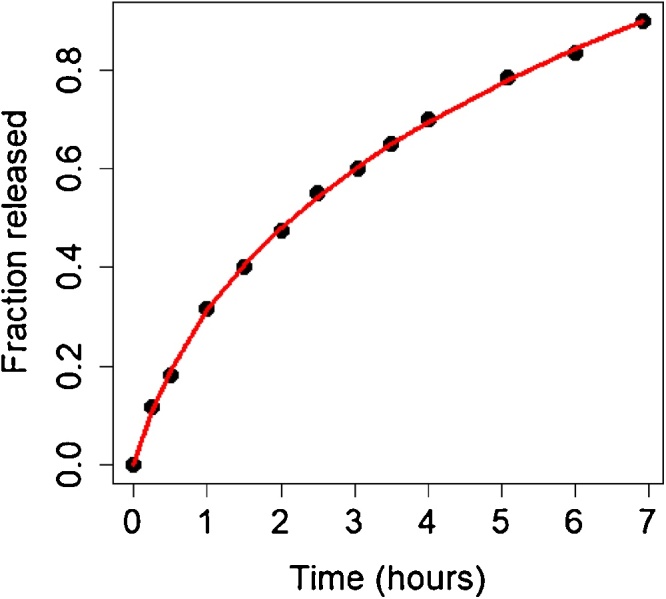
The experimental data points are accurately reproduced by a Monte Carlo heuristics, in which the predominant term in MCS is the deterministic one. Therefore, a Weibull model as defined in Eq. (3) (red curve) fits the entire release curve of chlorpheniramine maleate from HPMC K15M matrix tables (height 4 mm and height:radius ratio 1:1). The points are the experimental data reported in Siepmann et al. [2]. (For interpretation of the references to colour in this figure legend, the reader is referred to the web version of this article.)